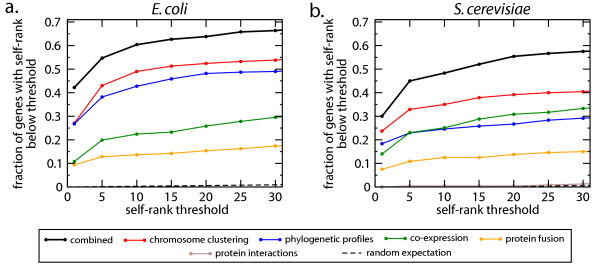
Enzyme predictions based on individual and combined types of association evidence (see Methods, Table 1). Fraction of known enzymes predicted within different self-rank thresholds is shown for a. E. coli metabolism and b. S. cerevisiae metabolism. Each curve indicates a probability (y axis) with which a true enzyme-encoding gene will be predicted within top n (x axis) candidates for its enzymatic function. The total number of candidates is 3352 for E. coli and 5253 for S. cerevisiae. Different curves demonstrate predictive performance of various types of association evidence. Predictions are generated based on functional association with the first three layers of the metabolic network neighborhood, using ADT classifier with 10-fold validation.